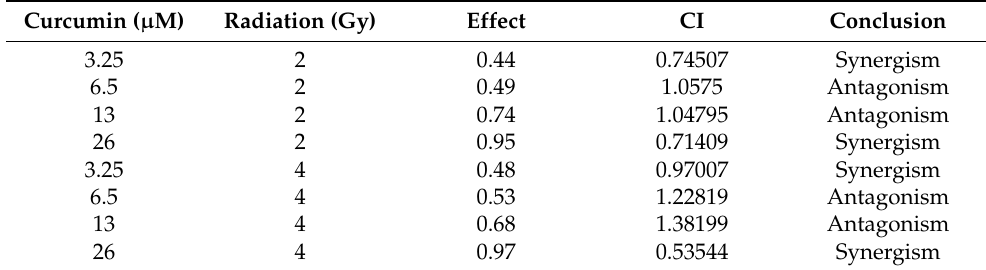
Table 2. Assessment of combinatorial effect of curcumin and radiation in T98 cells. CI was determined by CompuSyn software.